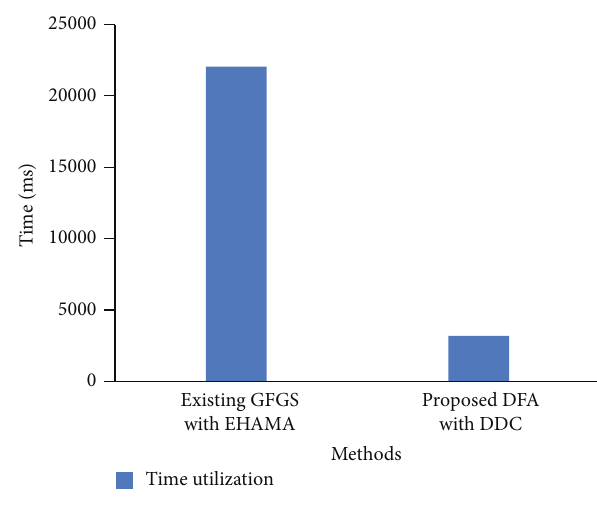
Figure 8: Time utilization